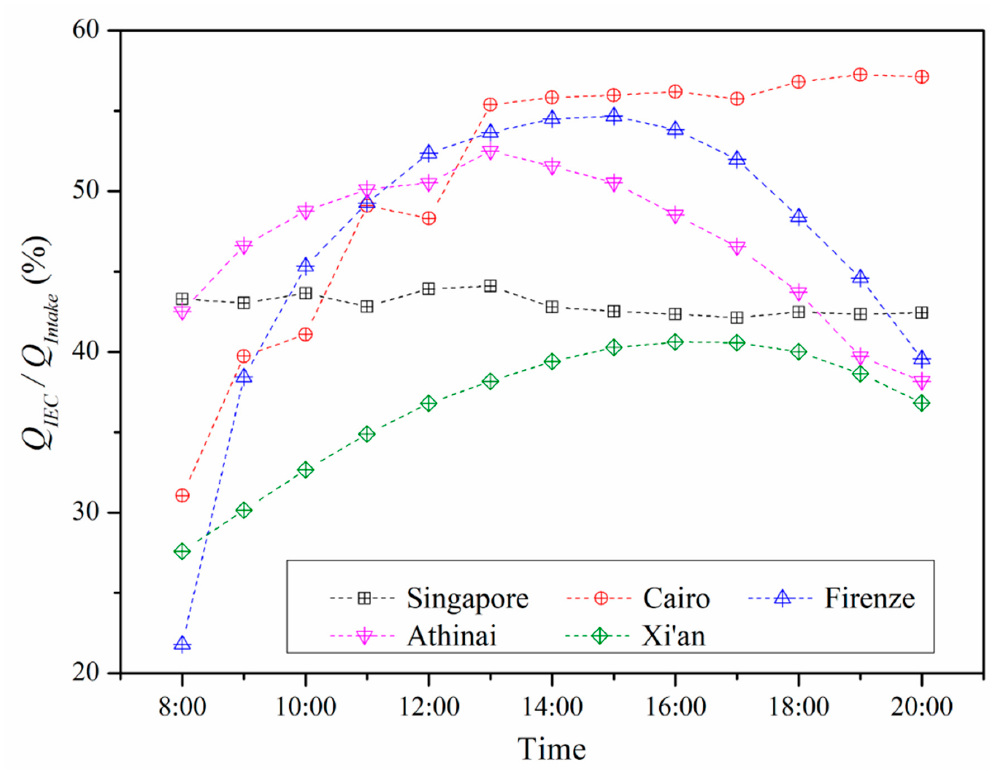
Figure 11. The percentage between the IEC pre-cooling capacity and the total cooling load for the ambient air.